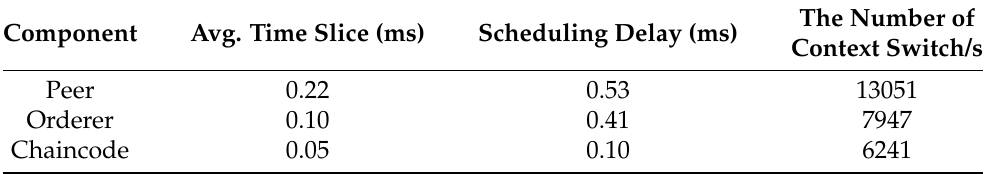
Table 2. System-level profiling of Fabric